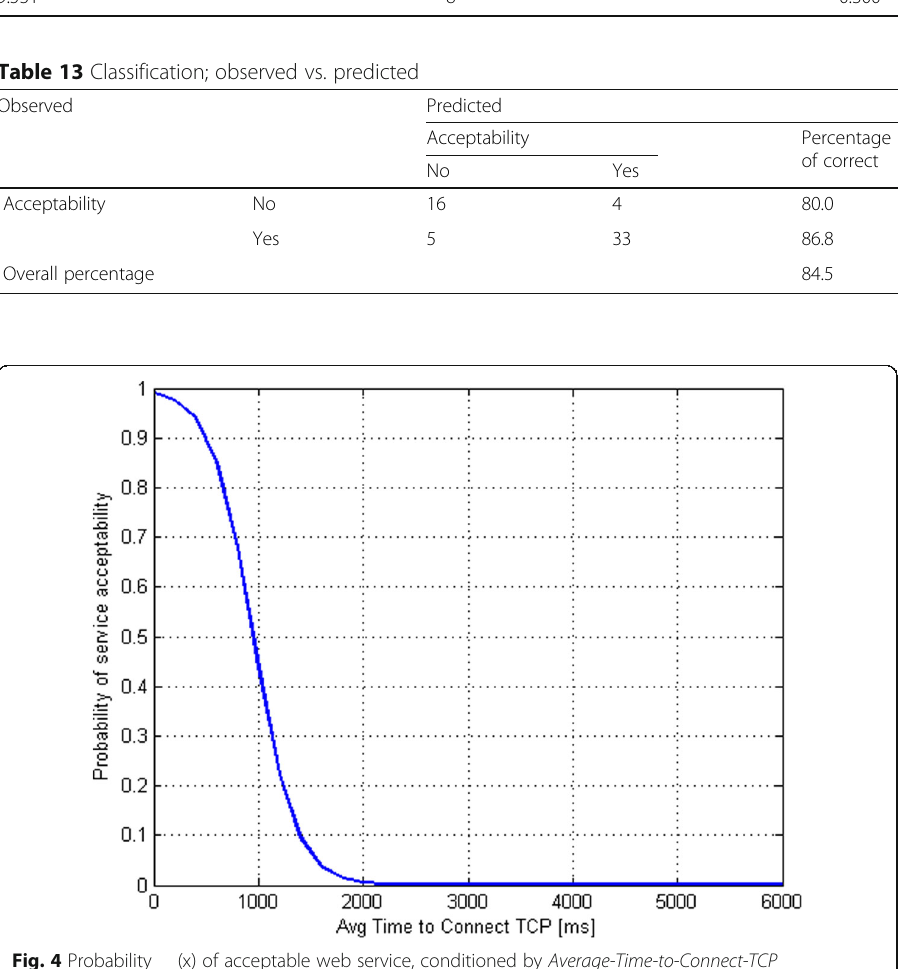
Table 12 Hosmer and Lemeshow test Chi-square